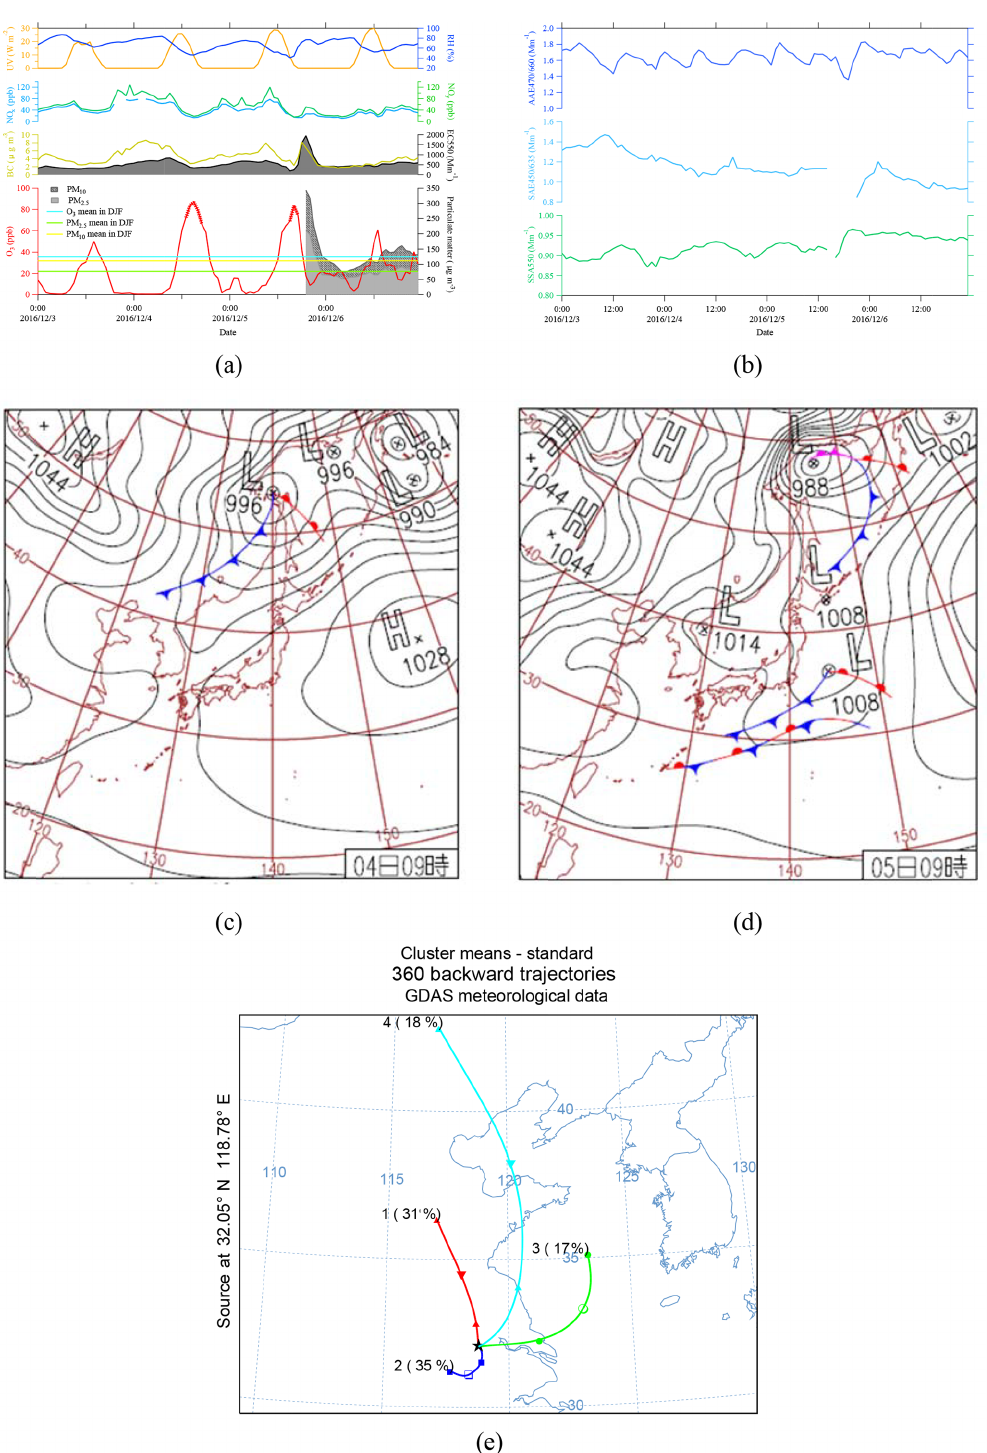
Figure 15. Time series during 3–6 December 2016 for (a) PM 2 . 5 , BC, and O 3 with associated metrological parameters, trace gases, and (b) optical parameters. Red markers represent O 3 over daily maximum average during winter. Weather charts on (c) 4 and (d) 5 December. (e) The 96h backward trajectory analysis ending at 12:00UTC on 5